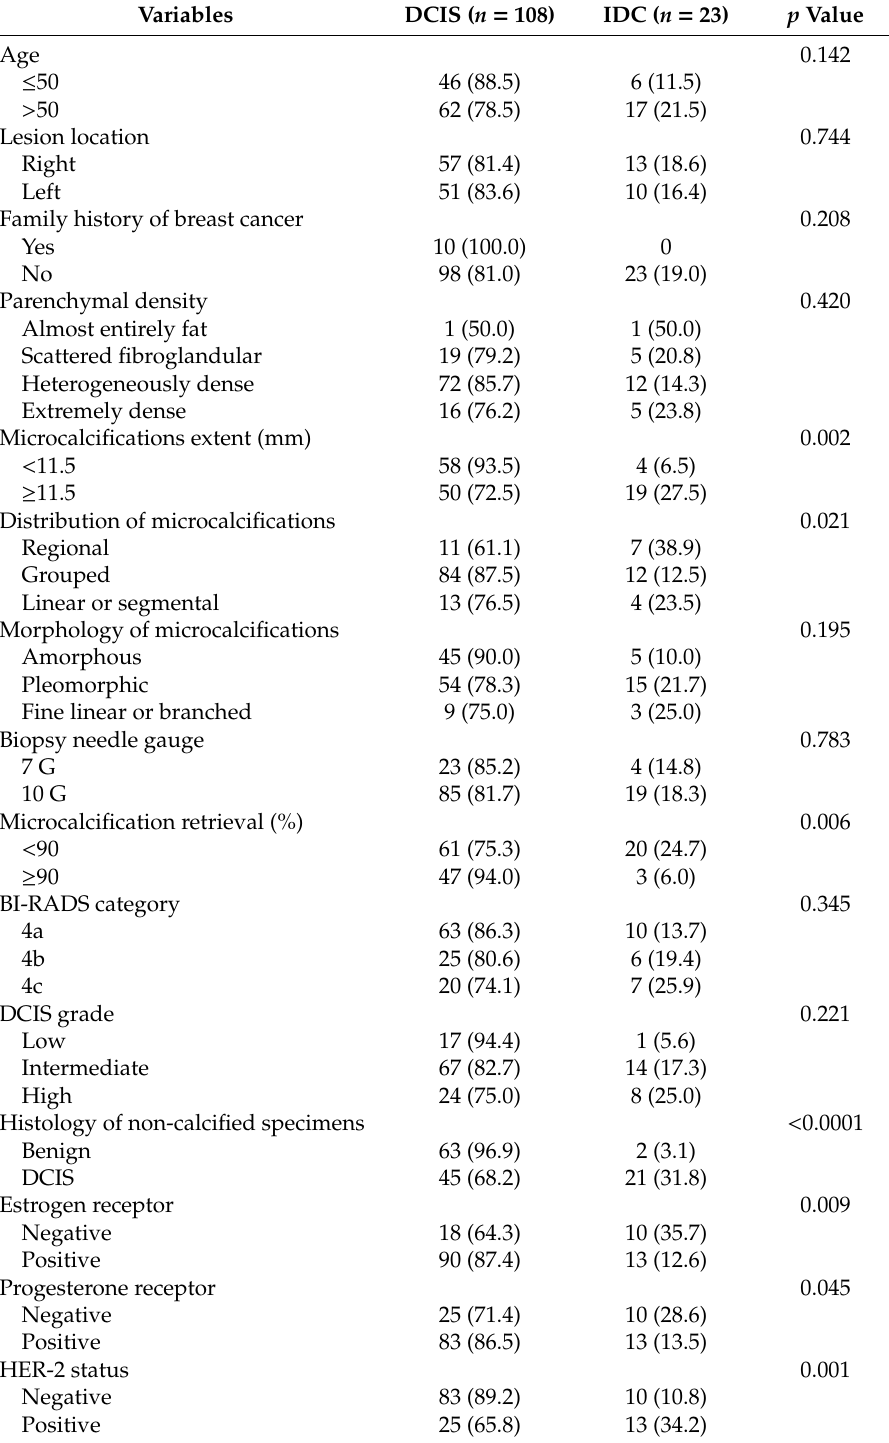
Table 2. Univariate analysis of the DCIS and upgraded